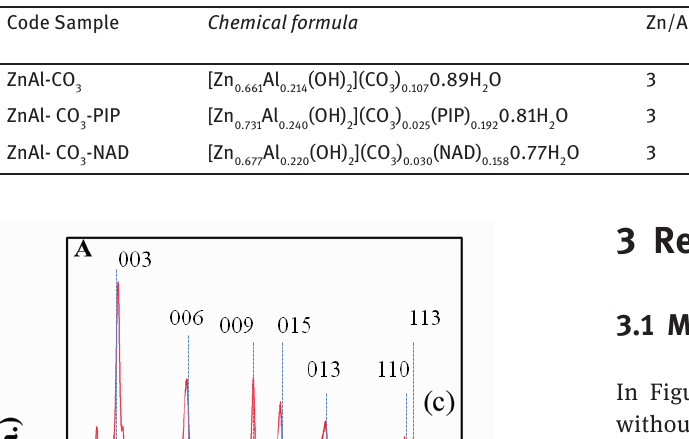
Figure 2: X-ray diff raction patterns of LDH-CO biocide, (b) containing pipemidic acid, and (c) containing nalidixic acid. As a reference, the lines with Miller index of hydrotalcite phase are